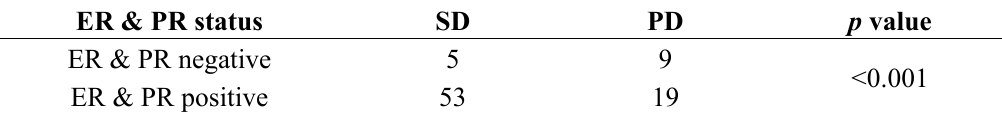
Table 6. Relationship between prognosis and ER & PR status.